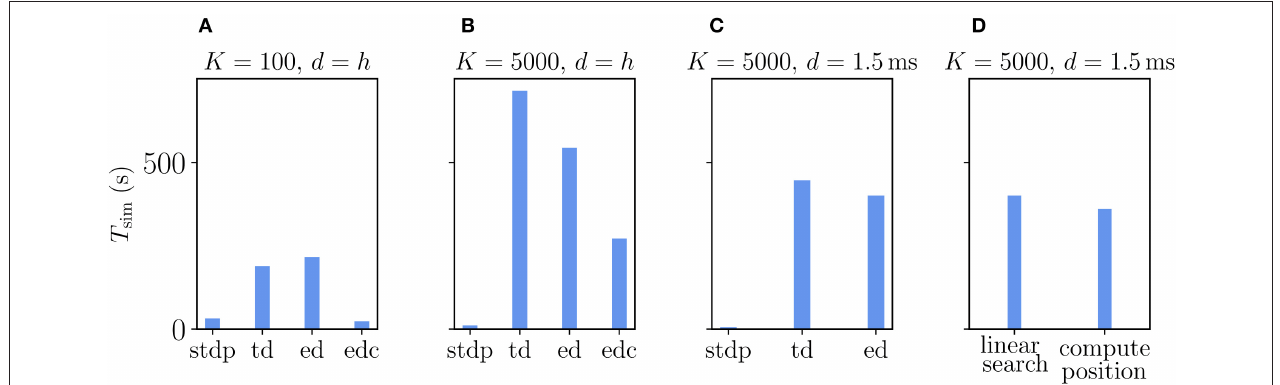
FIGURE 11 | Comparison of simulation times T sim for excitatory-inhibitory networks with different implementations of the Urbanczik-Senn plasticity in NEST. The following implementations are shown: “stdp”: standard implementation of STDP synapse in NEST, “td”: time-driven implementation of Urbanczik-Senn synapse, “ed”: event-driven scheme, edc”: event-driven compression. (A) Network of size N = 3.84 · 10 5 with small in-degree K = 100 and all synapses having a delay d equal to the resolution of the simulation h = 0.1ms. (B) Network of size N = 3.84 · 10 4 with large in-degree K = 5,000 and d = h . (C) Same network as in (B) but d = 1.5ms (for d > h “edc” not compatible with NEST, see section 3.1.3). In (A–C) both “ed” and “edc” use linear search of the history and the access counters, see Appendix Section 5.3 . (D) Comparison between “ed”-implementations using linear search and direct computation of the position, see Appendix Section 5.3.0.2 .